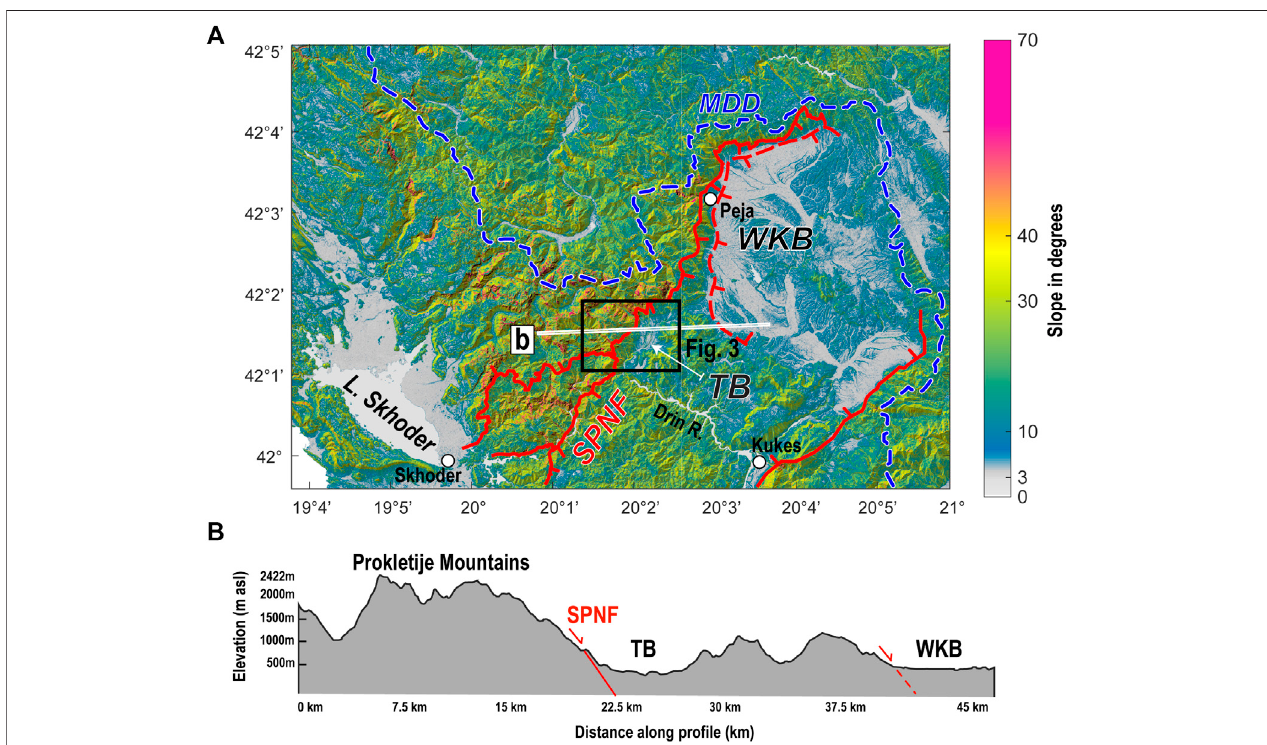
FIGURE 2 | Topography of the Dinaric-Hellenic junction: (A) Shaded slope map with major normal faults of the SPNF system marked as thick red line (surface exposure) and dashed red line (subsurface exposure). Blue dashed line – main drainage-divide (MDD). The slope analysis is based on SRTM-1 arc-second DEM (NASA, 2013); (B) Topographic cross-section along the trace in (a) includes the SPNF (solid red line) and related subsurface normal fault (dashed red line) bordering the Tropoja Basin (TB) and Western Kosovo Basin (WKB),